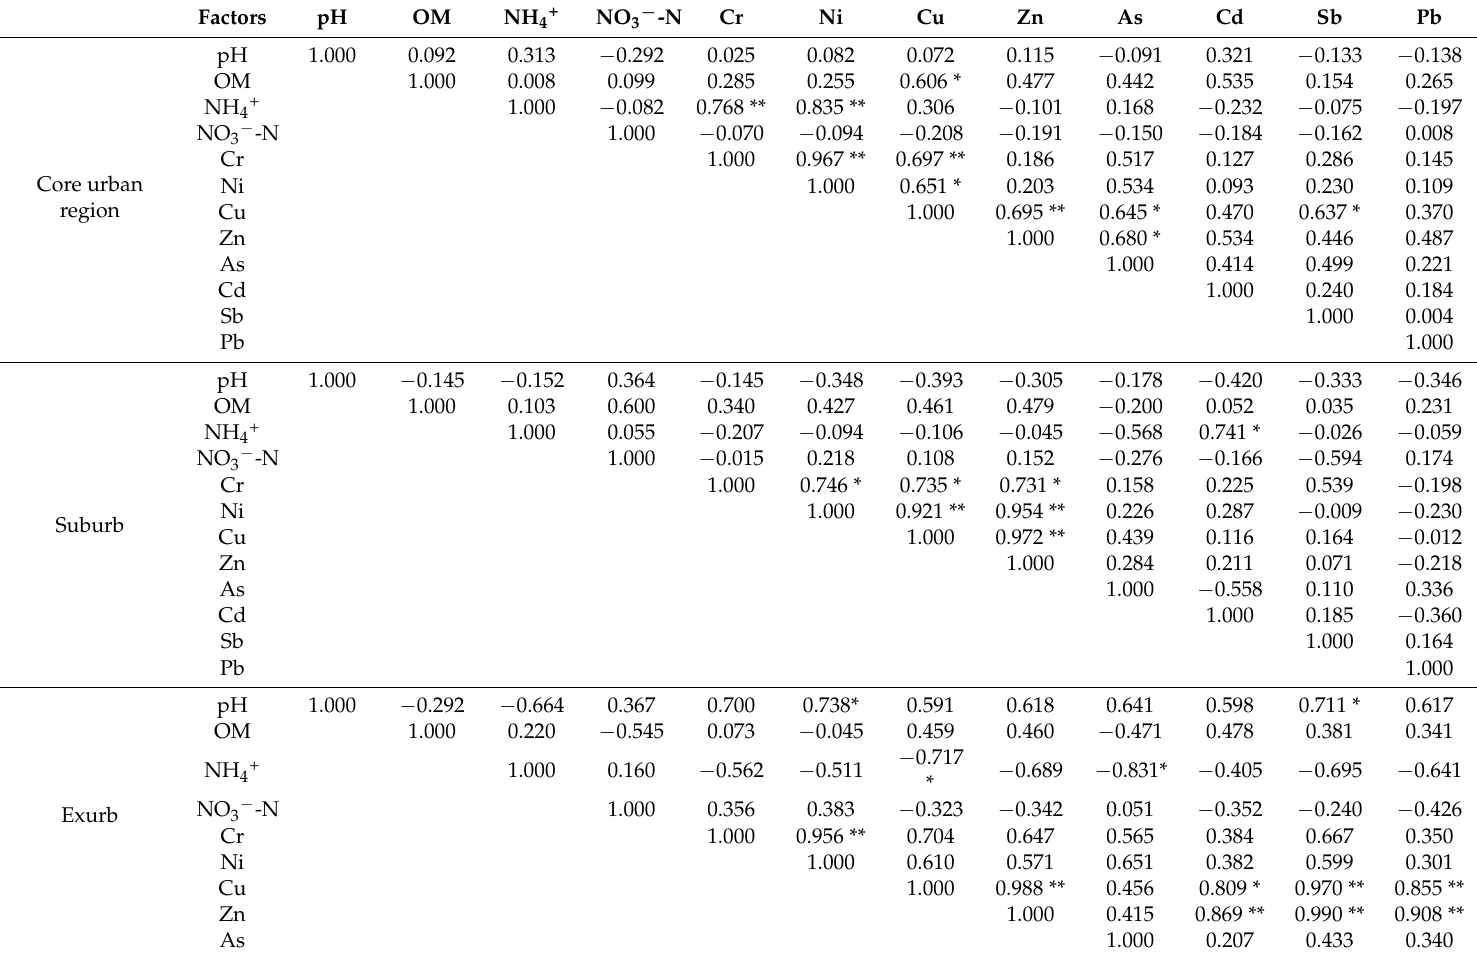
Table 3. Correlations among heavy metal in three urbanization